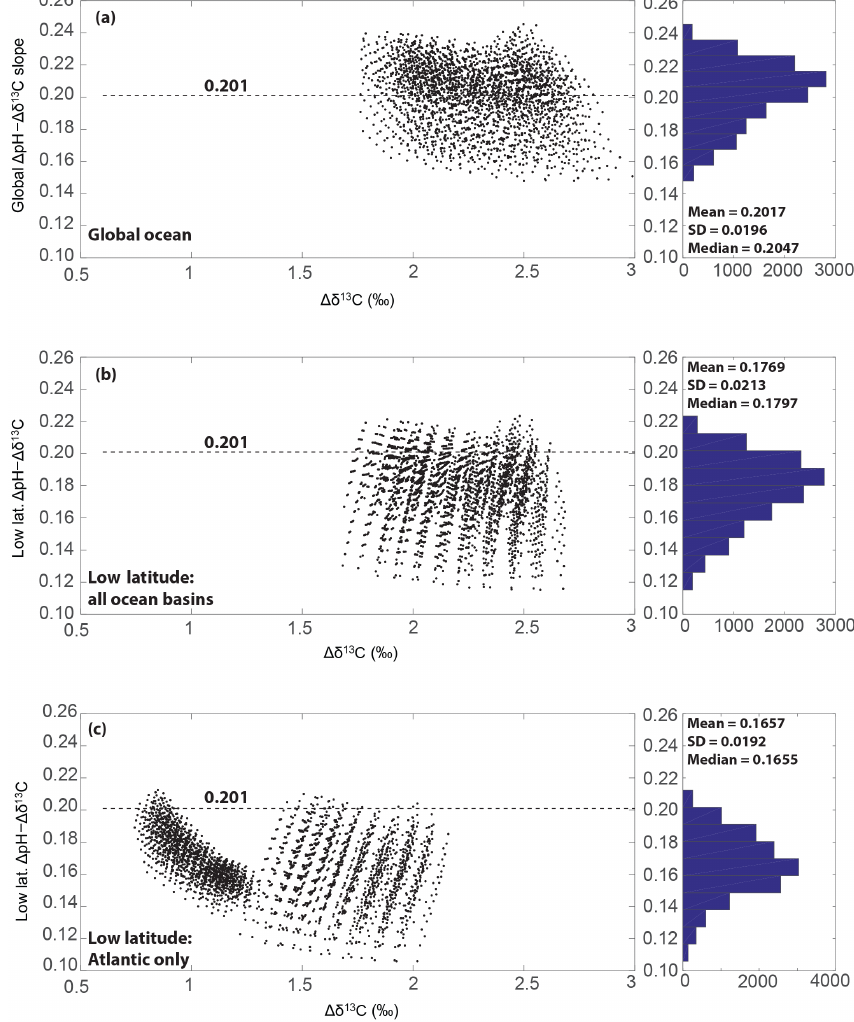
Figure 8. The output from sensitivity analysis of the relationship between pH gradient and δ 13 C gradient from the 13500-run CYCLOPS ensemble (see text for model details). Panel (a) shows the mean gradient when the results from all 18 ocean boxes are included in the regression. Panel (b) shows only the boxes from the low-latitude ocean from all basins and (c) shows the regression from only North Atlantic low-latitude boxes. Note the lower (cid:49) pH /(cid:49)δ 11 B slope at the lower latitudes due to the effect of temperature. The 0.201 line in each panel is the mean gradient when all the ocean boxes are included in the